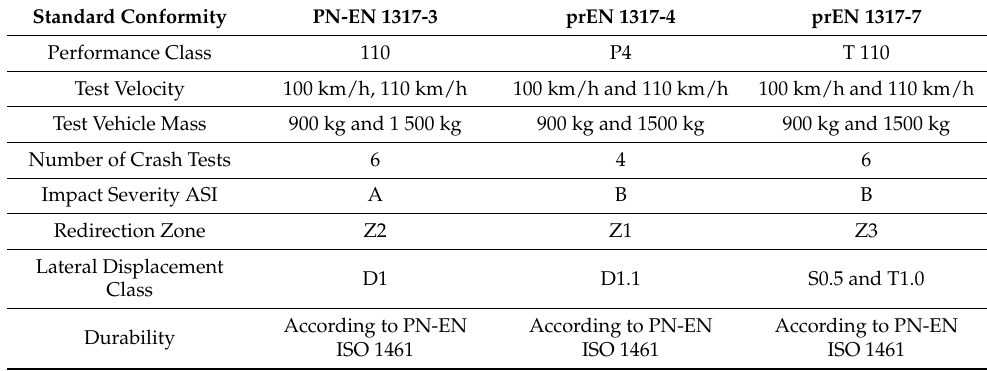
Table 3. Resulting test parameters for an SE device.